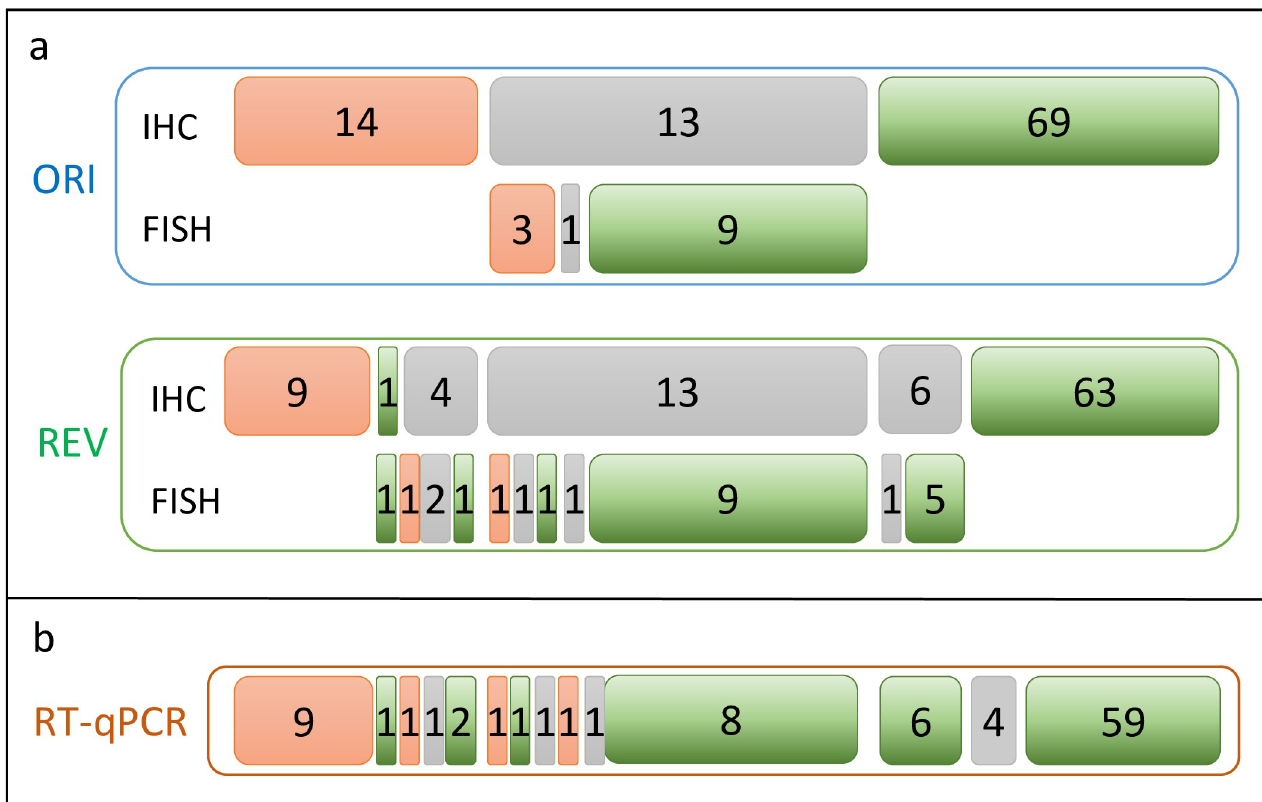
Fig 4. HER2 IHC/FISH discrepancies. Schematic analysis of discrepancies in HER2: a. between the original assessment (ORI) and re-evaluation (REV) and b. between IHC (ORI) and RT-qPCR. Positive calls are indicated by red filled boxes. Negatives calls are presented in green and equivocal calls in grey, according to the 2013 ASCO/CAP guidelines in force at the time of the